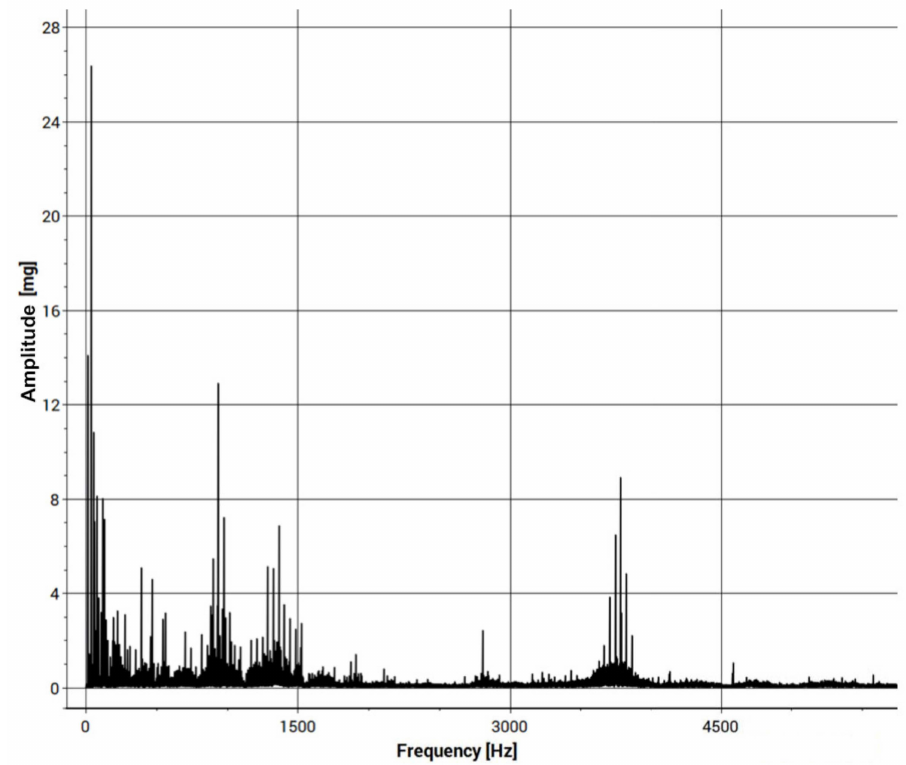
Figure 7. Fast Fourier Transformation of the input